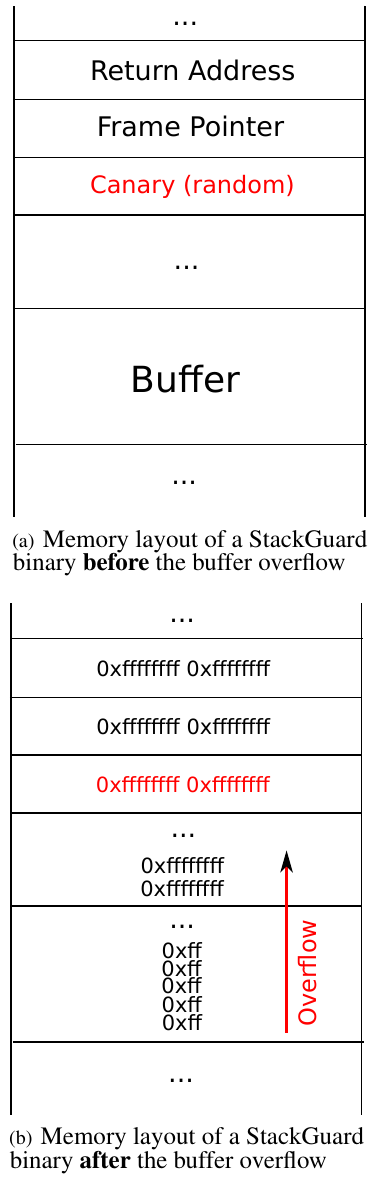
Figure 6. Memory layout of the exploit framework described by listing 11 compiled with StackGuard.